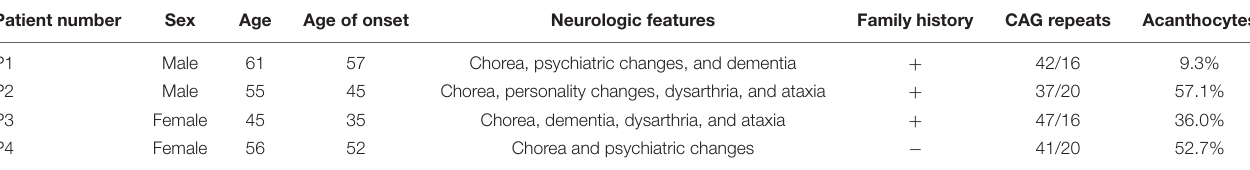
TABLE 1 | Main clinical features of the patients included in this